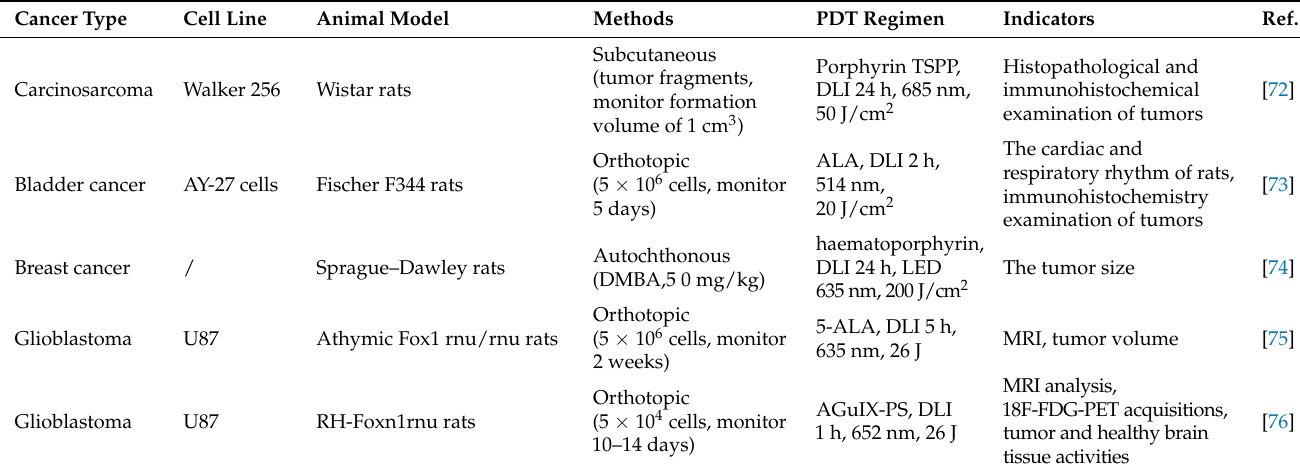
Table 5. Application of rats in antitumor study of